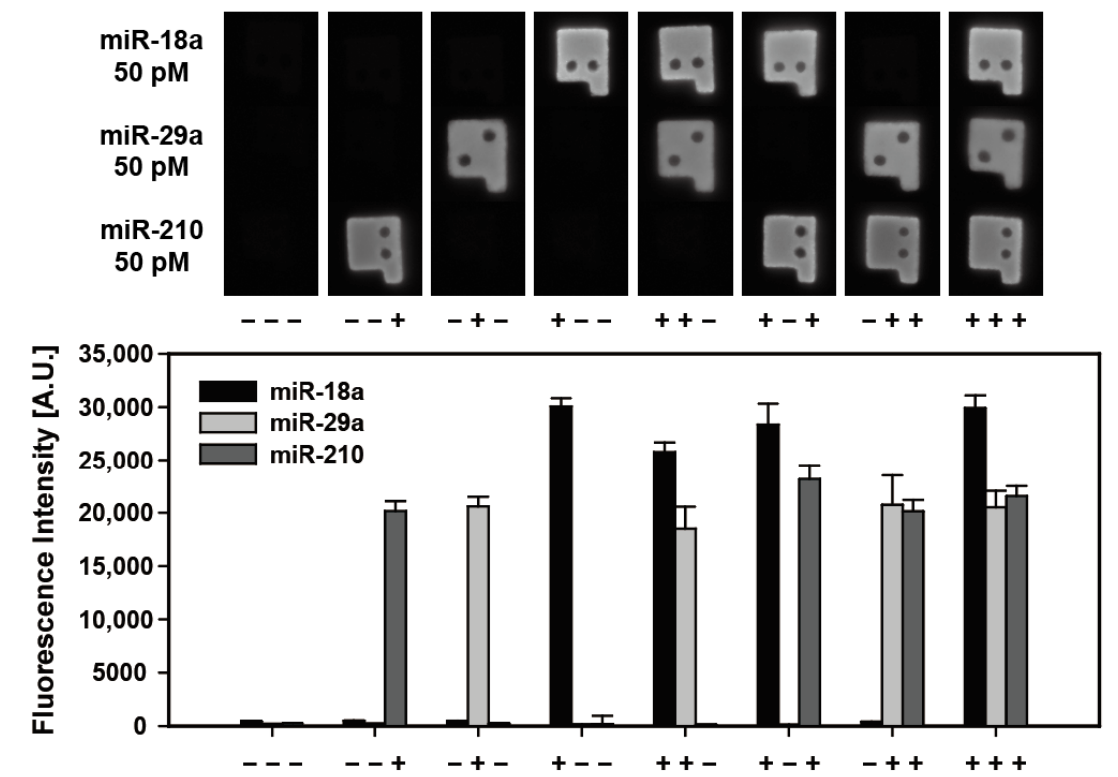
Figure 5. Multiplexed detection of three pre-eclampsia related miRNAs (miR-18a, miR-29a, and miR-210). The multiplexed detection was conducted for eight combinations of samples depending on the presence (+) or absence (−) of each target. The vertical bar graph indicates average fluorescence intensities of each target miRNA.